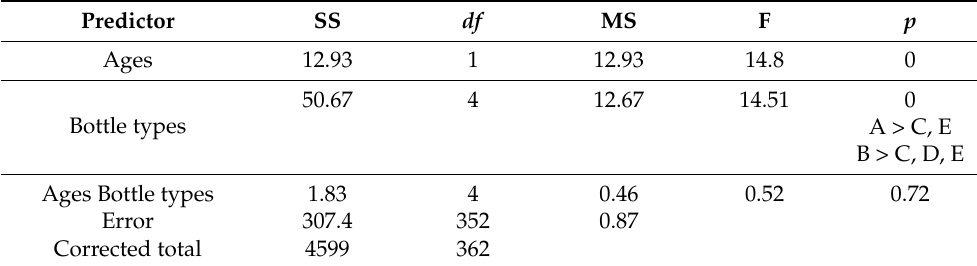
Table 5. Results of the two-way ANOVA for age group and bottle type.